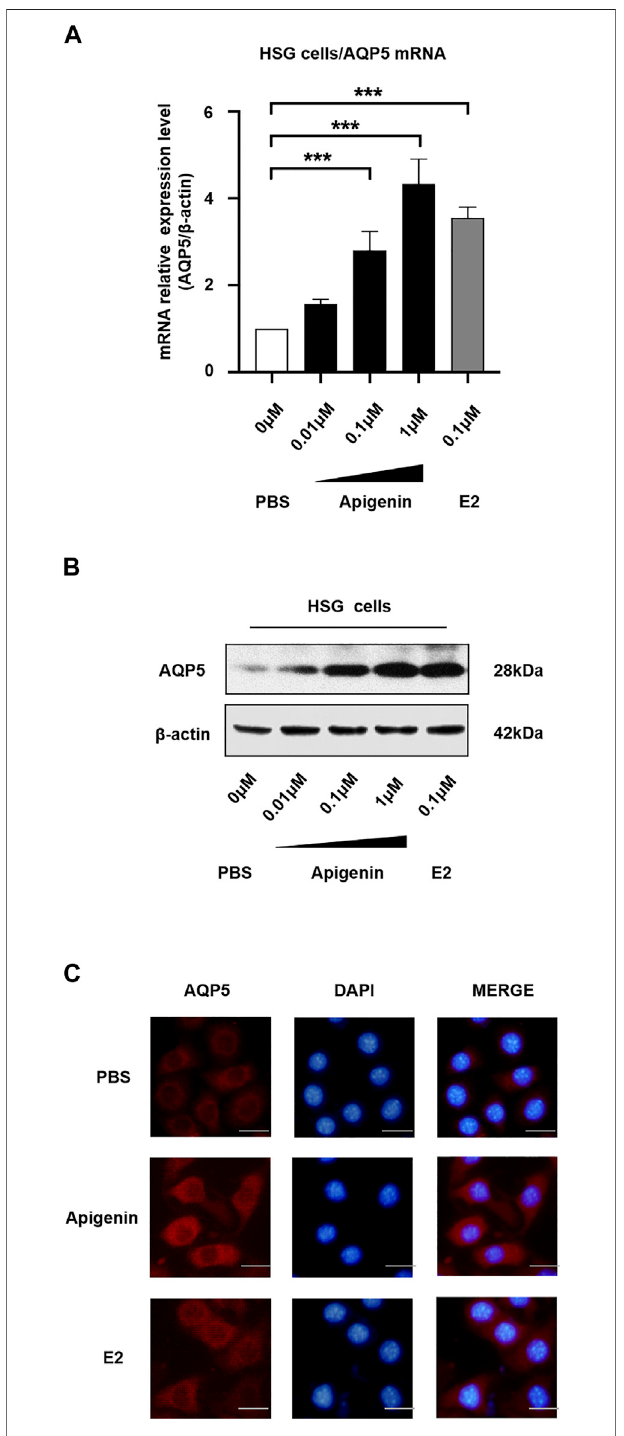
FIGURE 2 | Apigenin upregulates AQP5 transcription and expression. (A) mRNA relative expression level (AQP5/ β -actin) showing the AQP5 transcription in HSG cells by qPCR. (B) Apigenin upregulates AQP5 expression. Representative Western blot image showing endogenous AQP5 protein expression in HSG cells. (C) Immuno fl uorescence staining showing the AQP5 protein level and localization in HSG cells. Bar scale, 50 μ m. Data are presented as the mean ± SD, n = 3. Signi fi cant effect of the treatment, * p < 0.05, ** p < 0.01.